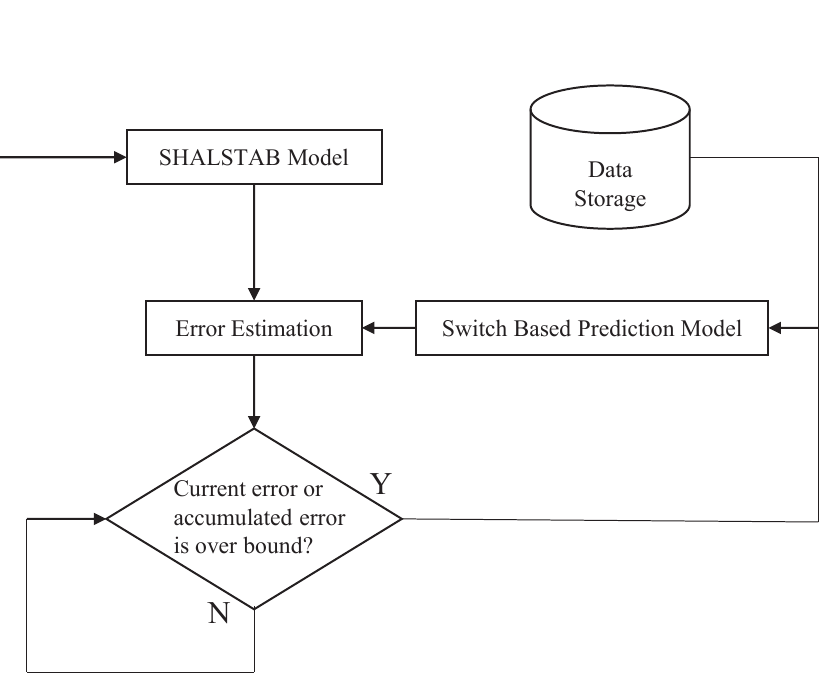
Figure 8. Learning-based re-training